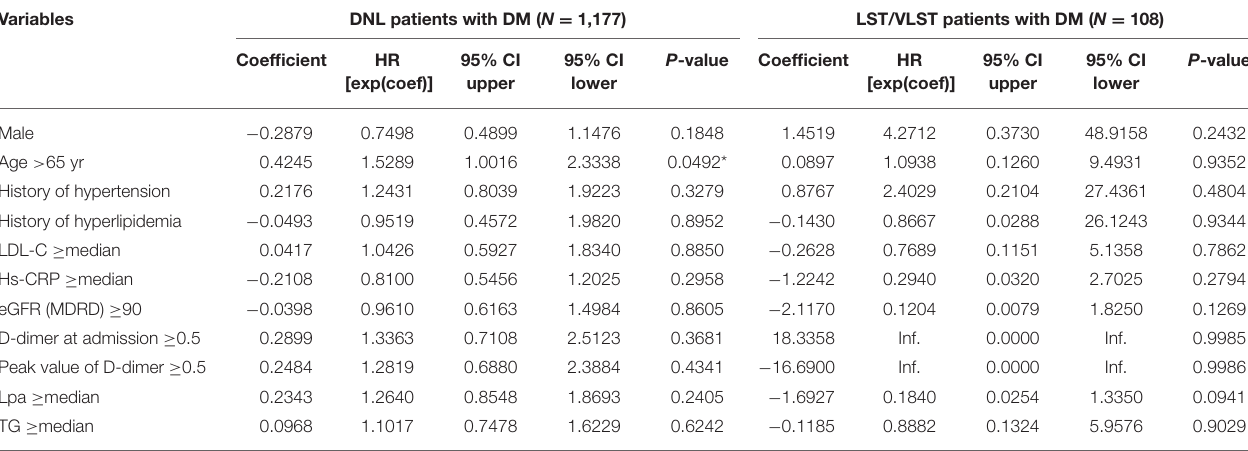
Peak value of D-dimer ≥ 0.5